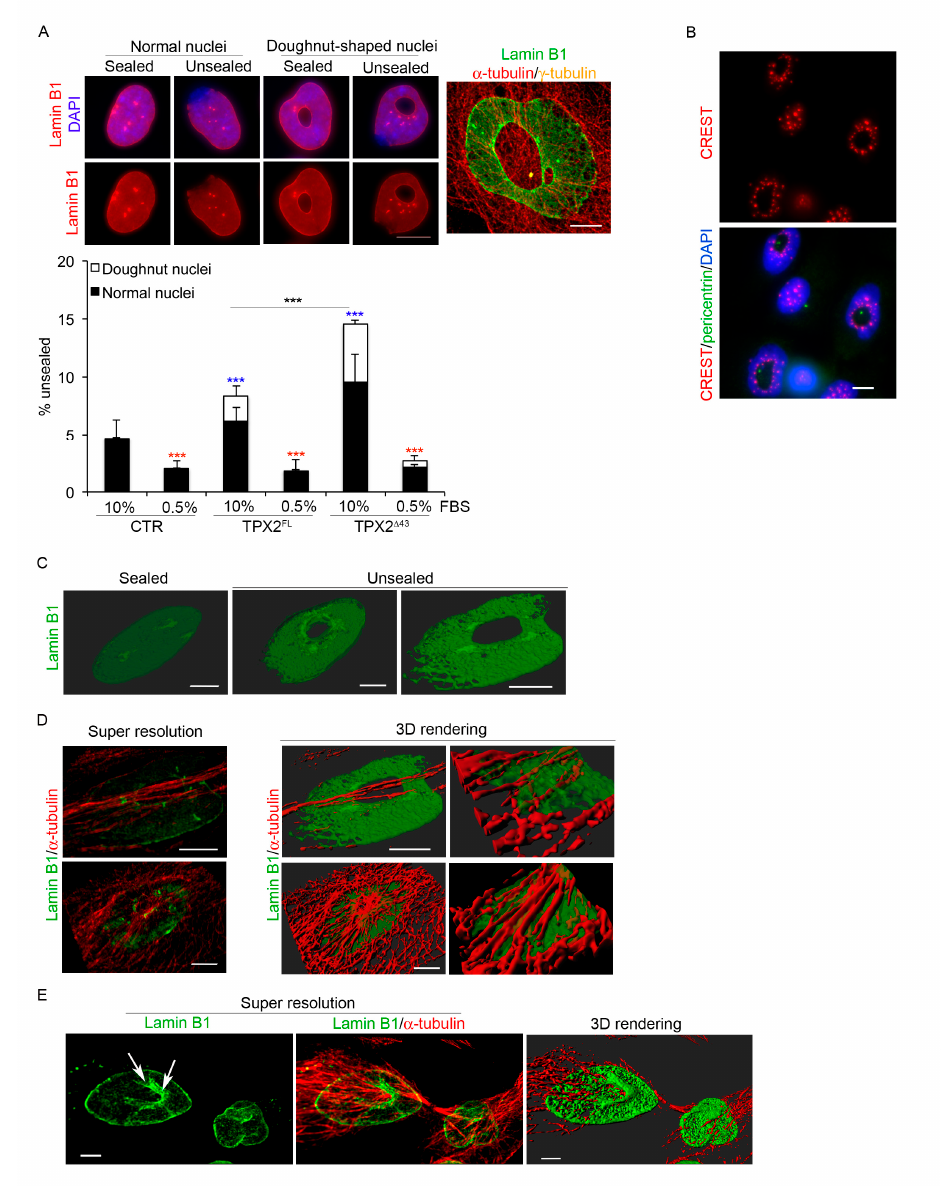
Figure 6. TPX2 overexpression interferes with lamin B1 organisation at the end of mitosis. ( A ) Overexpressing cells show a defective lamin B1 rim in normal and doughnut-shaped nuclei. The merged IF panel on the right is a super-resolved image exemplifying the defect. A total of 1500 cells were considered from three independent experiments for each cell line; s.d. are shown; *** p < 0.0001, chi-square (and Fisher’s exact) test. Blue asterisks refer to the difference from the control cell line, red ones to the difference, within each cell line, of serum starved cells (0.5% FBS) from control conditions (10% FBS). The statistical difference between TPX2 FL and TPX2 Δ 43 is also indicated. ( B ) Kinetochores (CREST, in red) organisation in doughnut-shaped nuclei is shown. The green signal comes from pericentrin staining, while VENUS fluorescence was lost due to methanol fixation. ( C ) Examples of 3D rendering of cell nuclei displaying sealed or unsealed lamin B1. ( D ) Examples of doughnut-shaped nuclei: left panels are volume views of super-resolved images, central ones are 3D rendering views; from the latter, enlargements of specific ROIs (Regions of Interest) are shown in right panels. ( E ) Volume view of a telophase cell with a doughnut-shaped nuclei forming, showing lamin B1 staining (left panel), merged with the α -tubulin signal (central panel). 3D rendering is shown on the right. Scale bars: 10 µ m for widefield images and 5 µ m for super-resolved